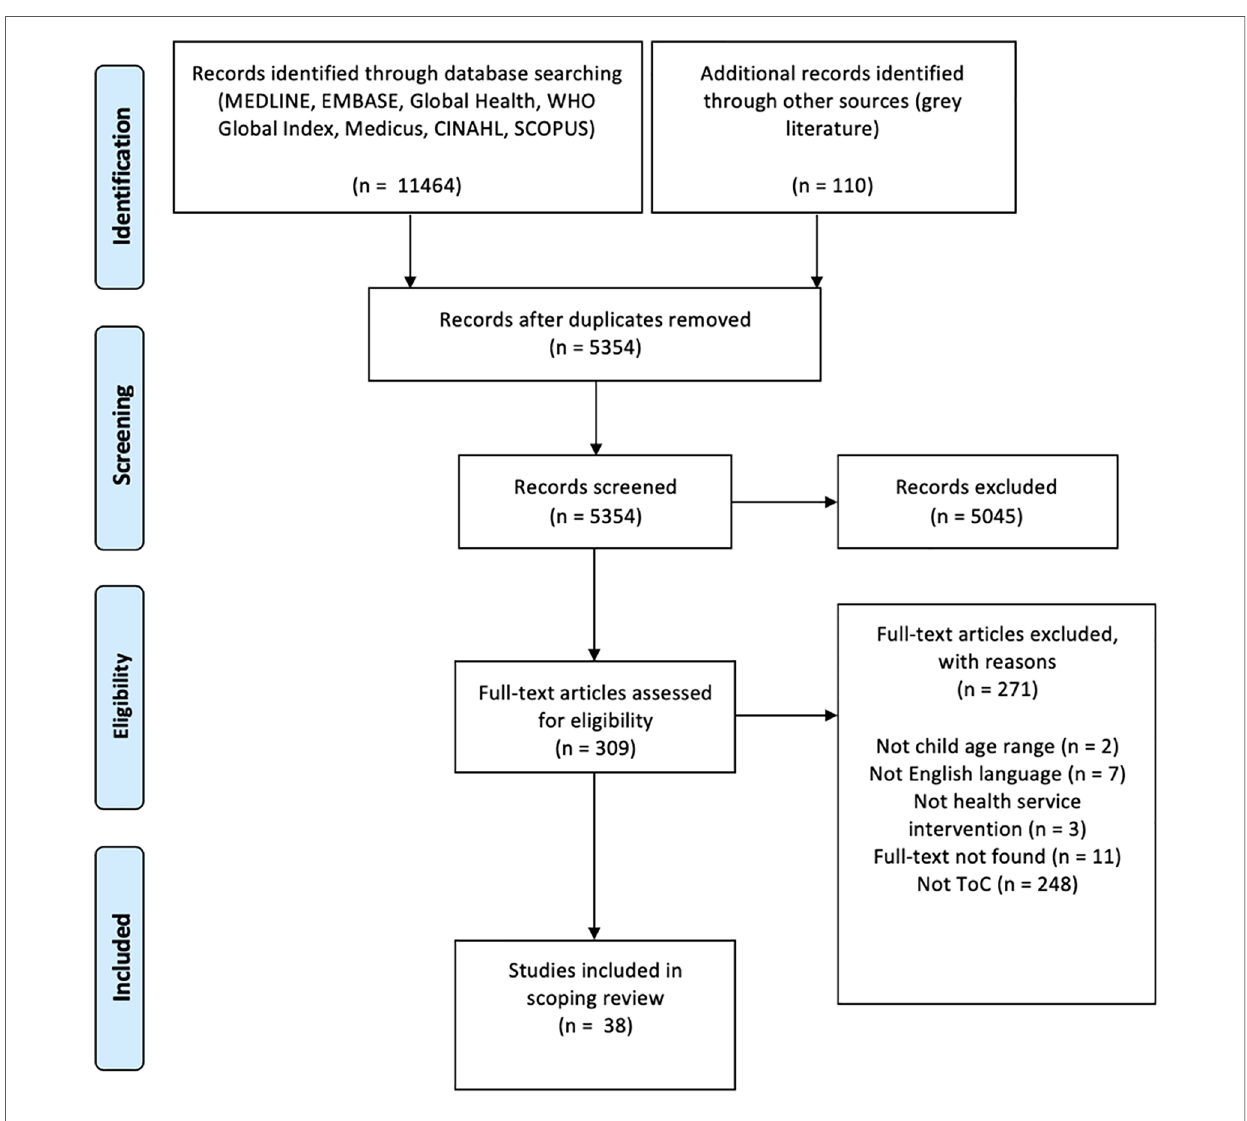
FIGURE 1 PRISMA-ScR fl ow diagram of search